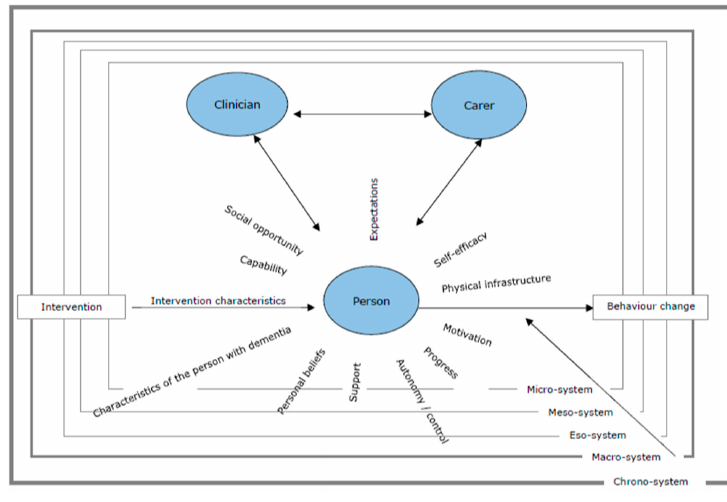
Figure 1. The original PHYT-in-dementia model [24].